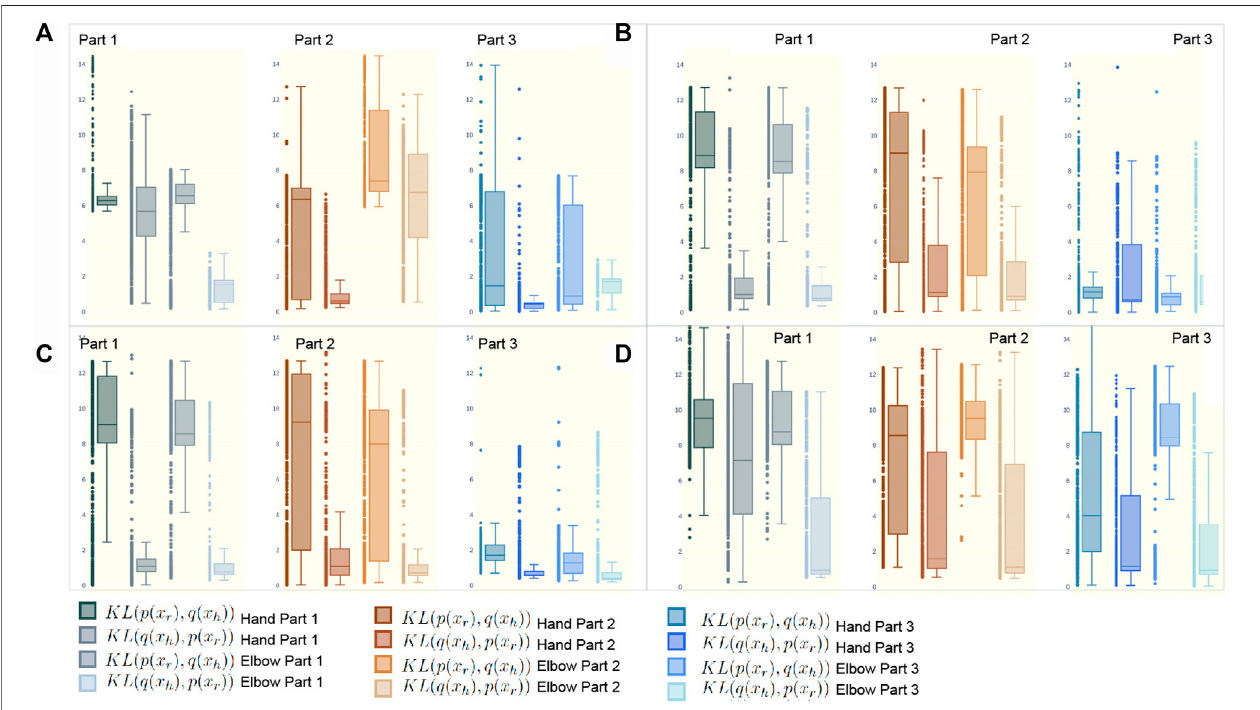
FIGURE14| KLdivergenceisrepresentedasameasureofdeviationbetweentherobotend-effectorandthehand( fi rsttwoboxplotsineachsubplot)andelbowof four participants panel (A – D) in the assistive task. For each participant there is a cooperation measure computed for each part of the experiment. The brown box plots shows a measure of the cooperation during cognitive